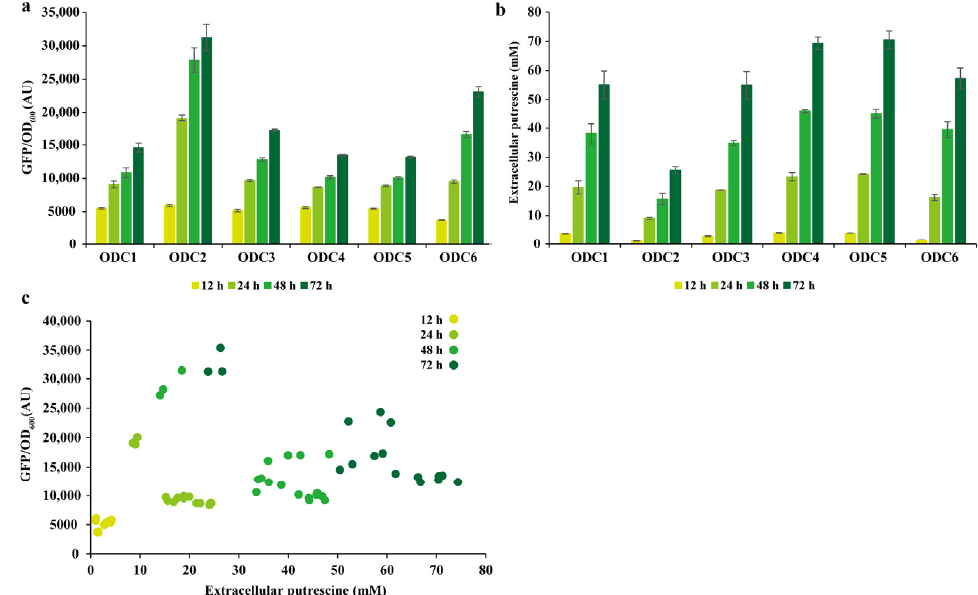
Figure 6. Putrescine biosensor for measuring extracellular putrescine concentration in recombinant strains containing ODCs. ( a ) Fluorescence-to-OD ratio of the recombinant strain containing ODCs measured at different fermentation time points; ( b ) extracellular putrescine concentrations for re- combinant strains containing ODCs at different fermentation time points. Values are presented as the mean ± standard deviations of three independent experiments. ( c ) Correlation between extracel- lular putrescine concentration and fluorescence ratio at different fermentation time points. ODC: ornithine decarboxylase .